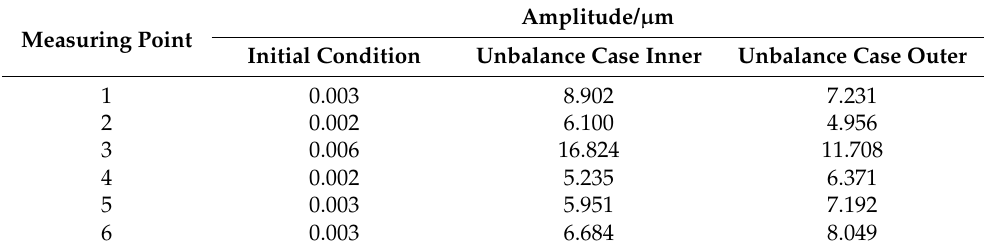
Table 1. Response of each measuring point.